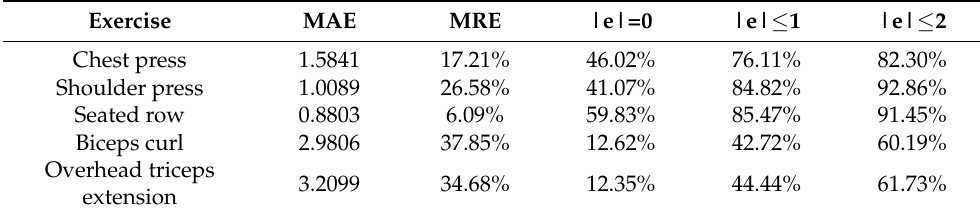
Table 13. Accuracy scores of the repetition counting algorithm.